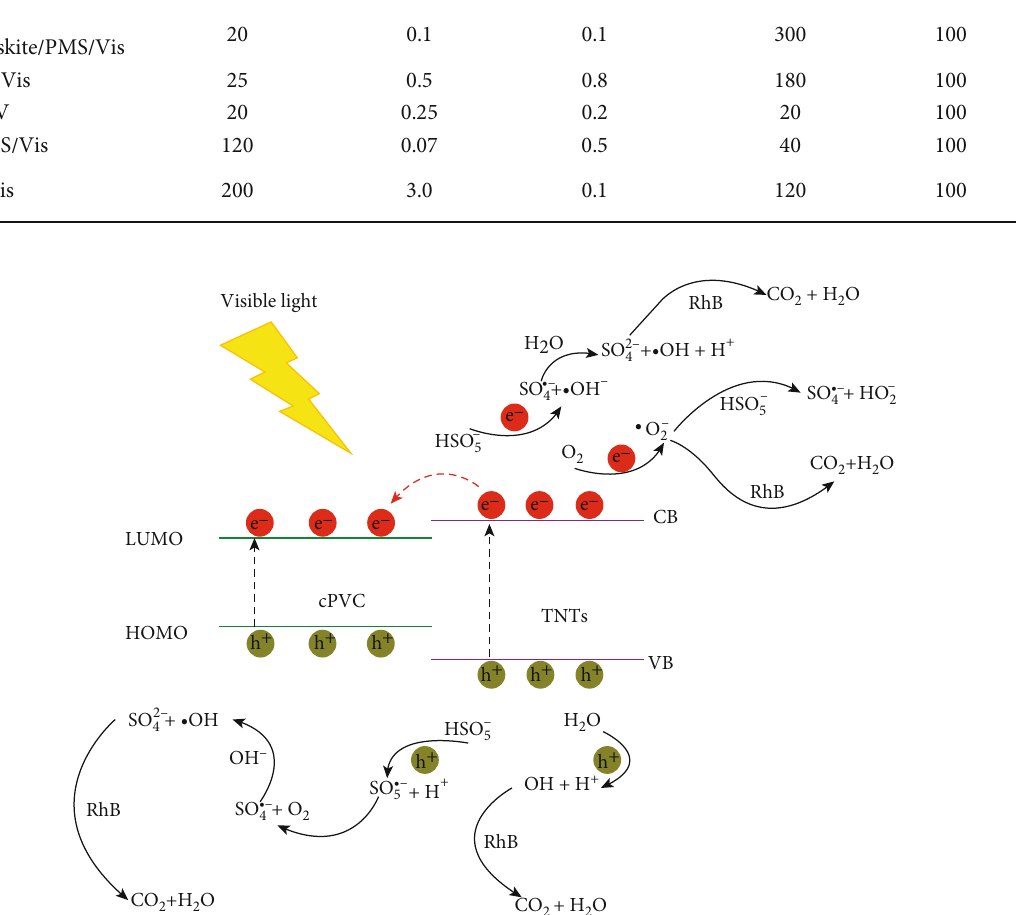
Figure 4: A schematic illustration of the photocatalytic degradation mechanism upon activation by PMS under visible